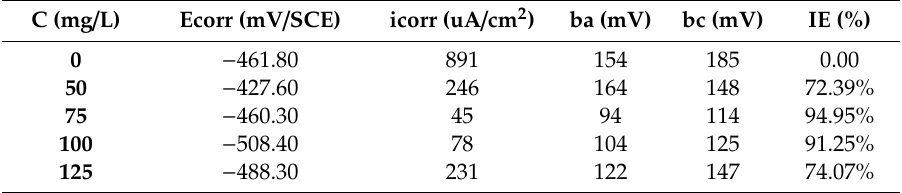
Figure 4. Polarization curves in a 1.0 mol/L HCl solution containing various inhibitor concentrations at 25 °C. 25 ◦ C. Table 2. Di ff erent electrochemical parameters of iron sheet in 1.0 mol / L HCl solutions at various Table 2. Different electrochemical parameters of iron sheet in 1.0 mol/L HCl solutions at various lignin-DMC lignin-DMC concentrations.